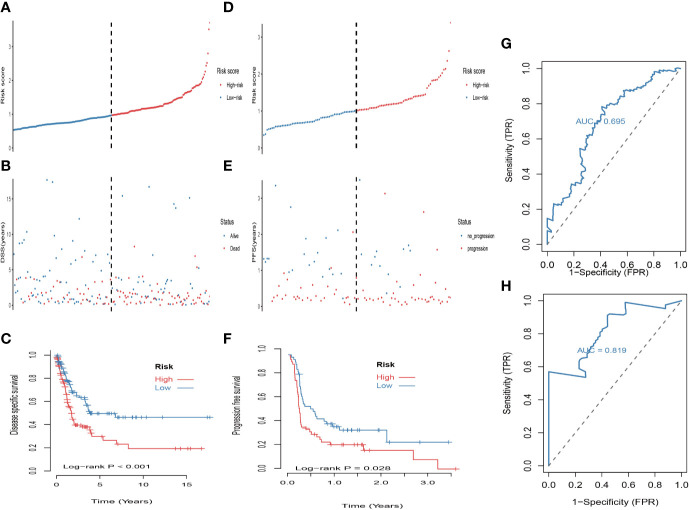
Validation of the prognostic value of the 5-MRGs biomarker in the GSE65904 and COHORT datasets. (A) The distribution of risk score for DSS. The risk scores are arranged in ascending order from left to right. (B) DSS and life status of melanoma patients. (C) The GSE65904 dataset was subjected to Kaplan–Meier analysis to compare DSS between patients in the high risk group and those in the low risk group; (D) The distribution of risk score for PFS (progression free survival). The risk scores are arranged in ascending order from left to right. (E) PFS and life status of melanoma patients. (F) The COHORT dataset was subjected to Kaplan–Meier analysis to compare PFS between patients in the high risk group and those in the low risk group. (G) The receiver operating characteristic (ROC) curves of 5-MRGs biomarker in GSE65904 for 3 years. (H) The ROC curves of 5-MRGs biomarker in COHORT for 3 years.